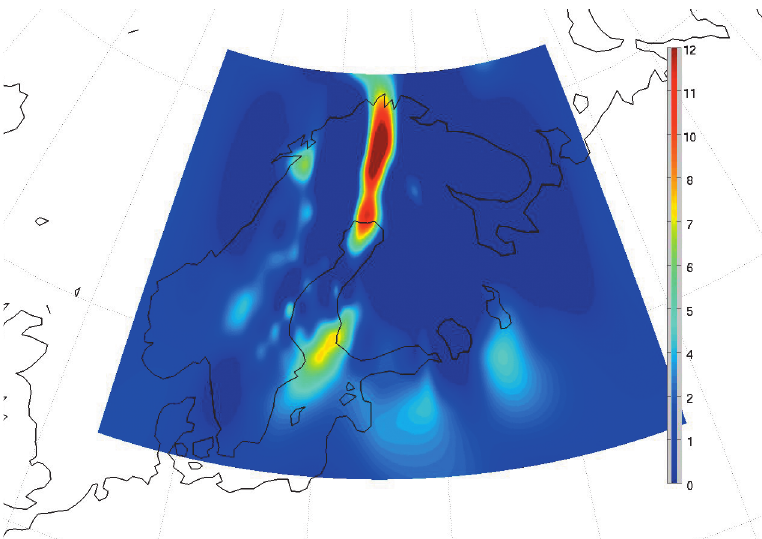
Fig. 2. A regional TEC map retrieved from slant GPS observations with the MIDAS algorithm. The colour bar shows the TEC values in TECU (1 TECU = 10 16 electrons/m 2